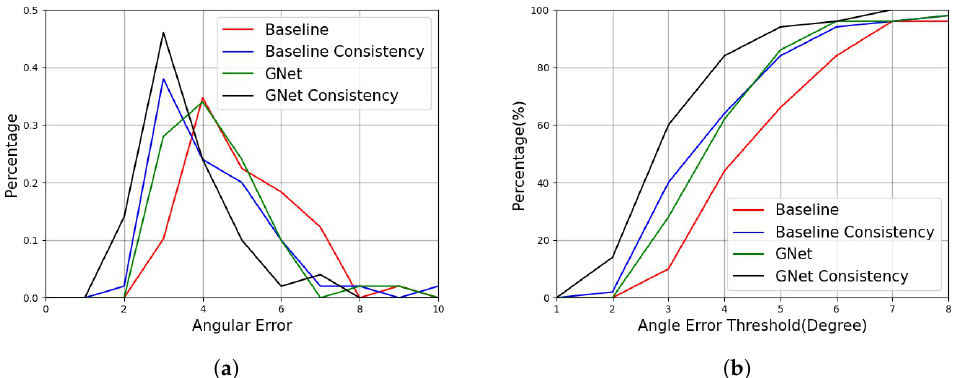
Figure 9. The gaze error distribution on the UT-Multiview dataset: ( a ) the percentage of different errors; ( b ) the percentage of correct samples under different thresholds.